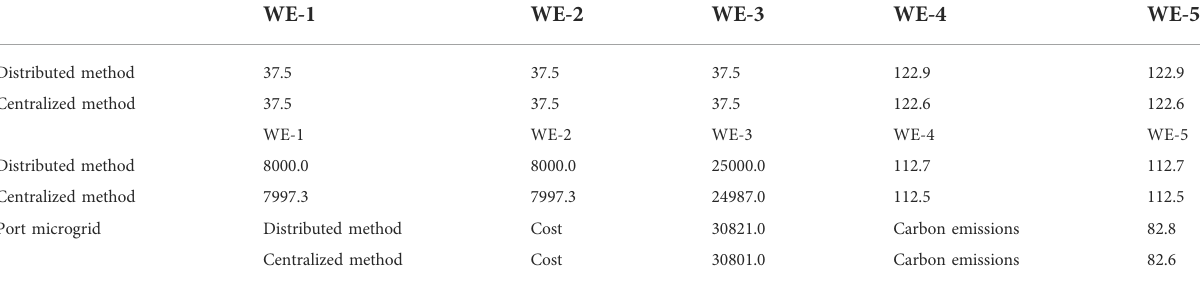
TABLE 2 Operating data of